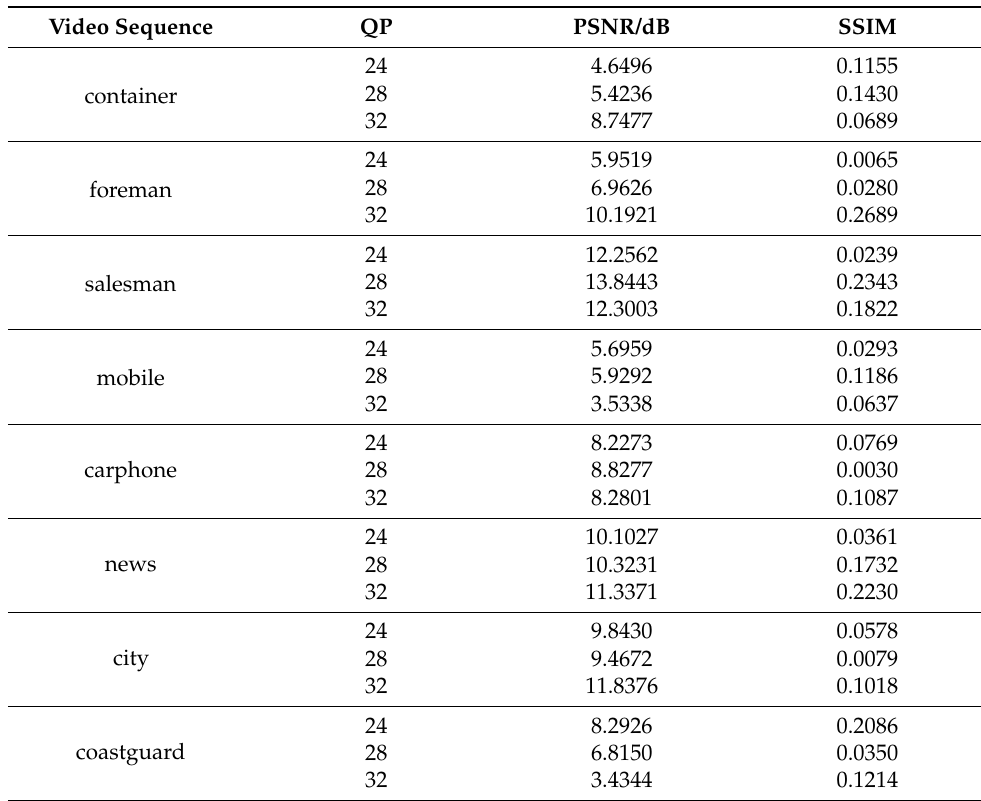
Table 1. PSNR and SSIM after